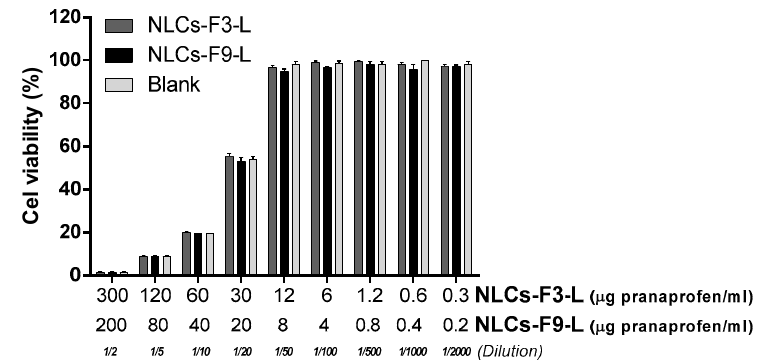
Figure 7. Cell viability percentage of HaCaT cells treated with different concentrations of NLCs-F3-L and NLCs-F9-L after 24 h of incubation. Results are shown as mean ± SEM of 3 independent experiments ( p < 0.05).